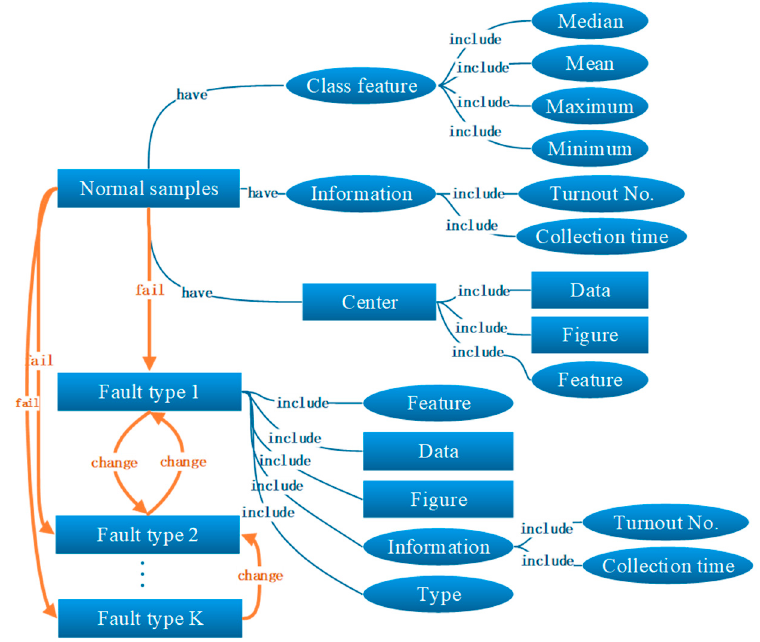
Figure 5. Structure of feature-based knowledge graph.